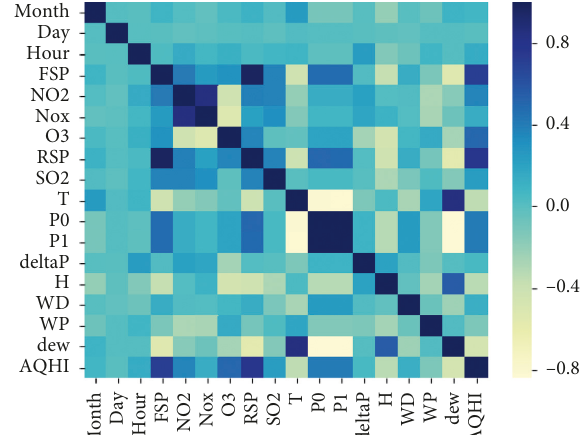
Figure 3: Spearman correlation between features.